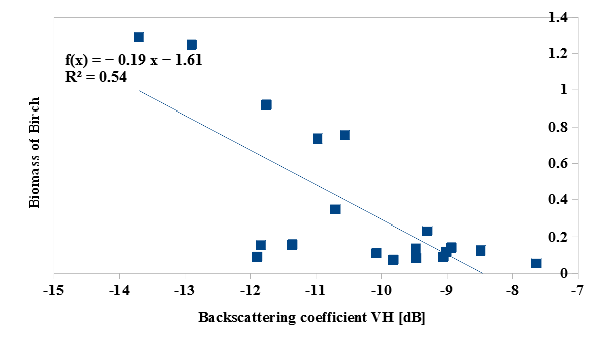
Figure 4. The relationship between the Birch biomass and the backscattering coefficient VV